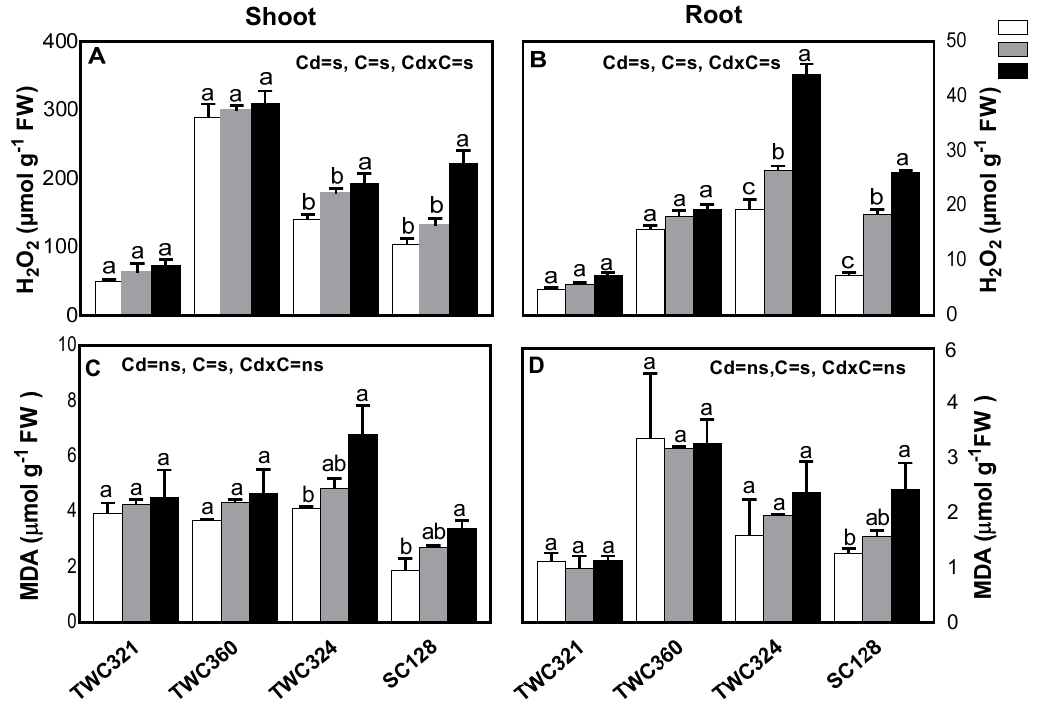
Figure 3. Effect of Cd-stress (C: control, M: mild and S: severe) on ( A , B ) hydrogen peroxide (H 2 O 2 ) and ( C , D ) malondialde- hyde (MDA) content of maize shoot and root, respectively. Values are expressed as means ± SE ( n = 5). Bars with at least one similar letter within each cultivar indicate non-significant difference ( p ≤ 0.05). Two-way ANOVA was applied to study the effect of the two factors, Cd-stress (Cd) and cultivars (C), as well as their interaction (Cd × C). To reveal whether the tolerance of TWC321 and TWC360 under Cd ‐ stress was asso ‐ ciated with their modulation of the antioxidant defenses, we measured the activity of SOD, CAT and POX and their efficiency to scavenge the resultant ROS (Figure 4A–F). The activity of SOD varied among the respective organs of the investigated cultivars, particu ‐ larly shoots, as a response to Cd exposure. In shoots, the activity of SOD was stimulated significantly in tolerant cultivars, TWC321 and TWC360, in response to Cd ‐ stress. The moderately sensitive cultivar TWC324 exhibited a significant stimulation of SOD only at severe stress, while SC128 did not show any significant change (Figure 4A). Additionally, SOD stimulation in tolerant cultivars was observable at both mild and severe stress, indi ‐ cating that the tolerant cultivars started to induce SOD at the threshold of Cd ‐ stress. The strongest increase was monitored in TWC321 cultivar. Our data also suggested that SOD activity was already stimulated at the lower stress level and in the cultivars with less Cd accumulation. The activity of SOD was increased in roots of all four cultivars, and the increment was more in the sensitive ones (Figure 4B). While TWC360 dramatically in ‐ creased the activity of CAT and POX in root, it significantly decreased the former and stimulated the later in its shoot (Figure 4C–F). Notably, the cultivar SC128 showed a sim ‐ ilar, but weaker response. Both TWC321 and TWC324 stimulated CAT and POX in their